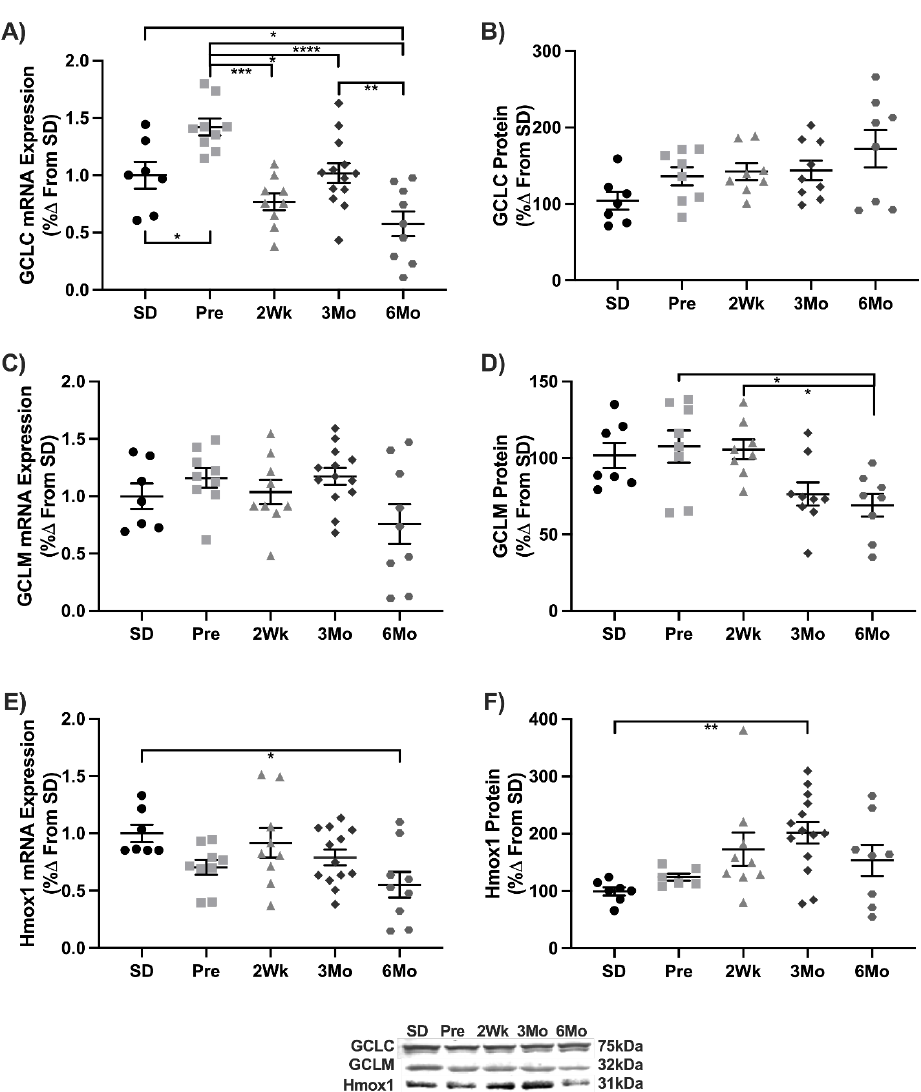
Figure 4. Downstream targets of cardiac Nrf2 activation are decreased or unchanged six months after the onset of T2DM. Mean ± SEM values of ( A ) GCLC mRNA, ( B ) GCLC protein, ( C ) GCLM mRNA, ( D ) GCLM protein, ( E ) Hmox1 mRNA, and ( F ) Hmox1 protein in Sprague-Dawley (SD; n = 7), pre-diabetic UCD-T2DM (Pre; n = 9), 2-week diabetic UCD (2Wk; n = 9), 3-month diabetic UCD-T2DM (3Mo; n = 14), and 6-month diabetic UCD-T2DM (6Mo; n = 9) rats. * p < 0.05, ** p < 0.01, *** p < 0.001, **** p <